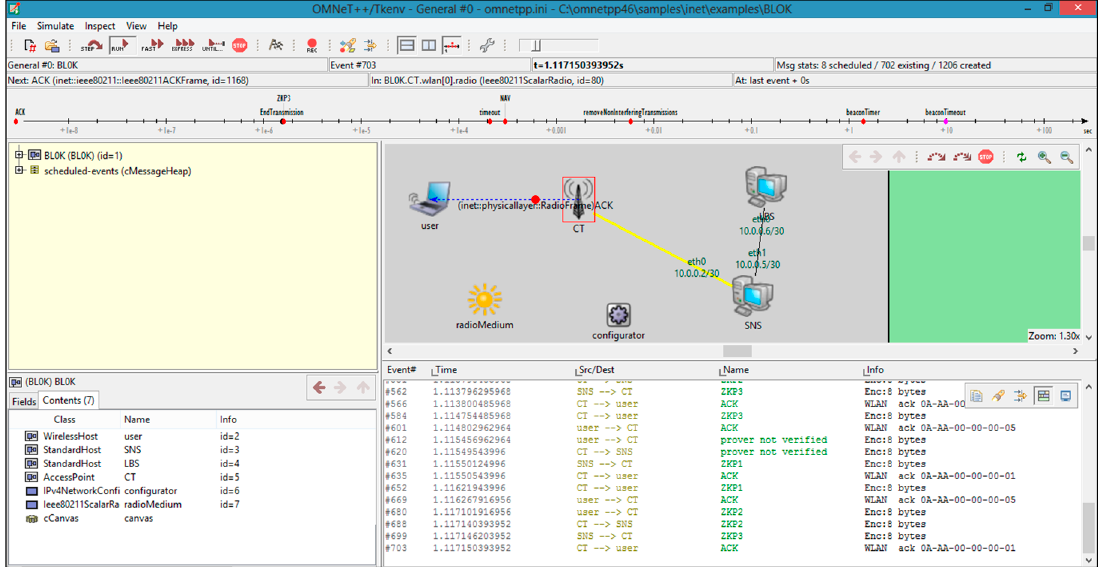
Figure 10. A snapshot of BL0K modeling.